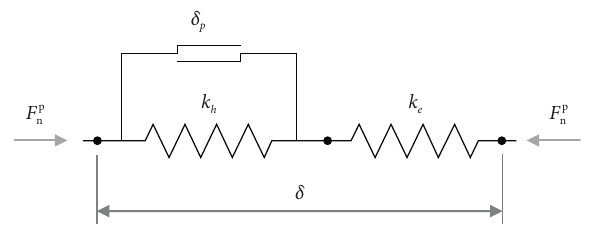
Figure 10: Schematic diagram of the elastoplastic normal contact model for particle